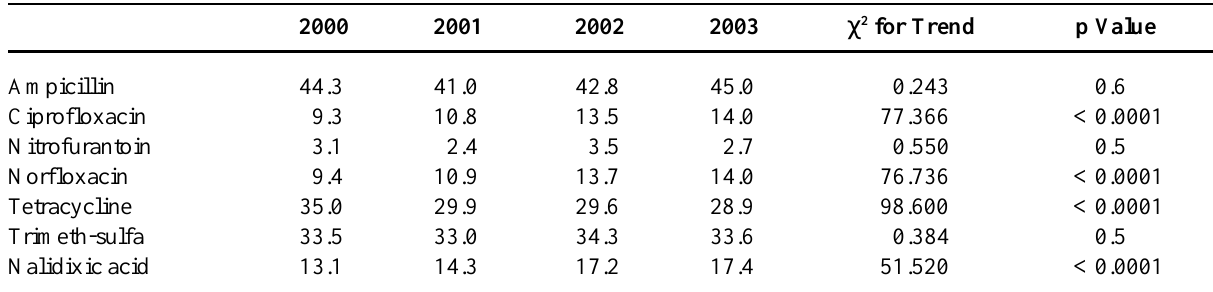
Table 4 – Chi-square test for trend applied to E. coli resistance rates (%) to various antimicrobials in 4 surveyed years (2000 to